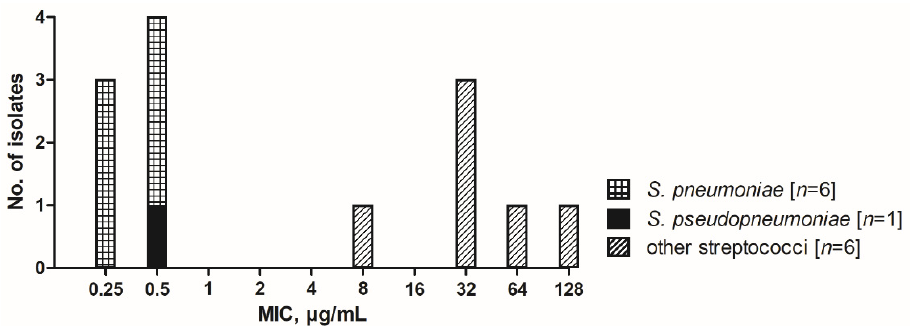
Figure 1. Distribution of MICs within the development set isolates to determine an optimal optochin breakpoint concentration for following test development.